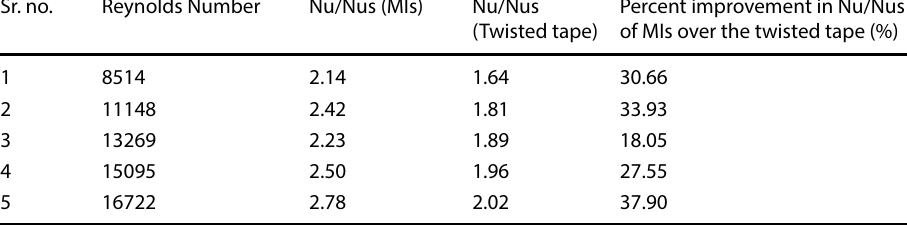
Table 1 Percent improvement of heat transfer